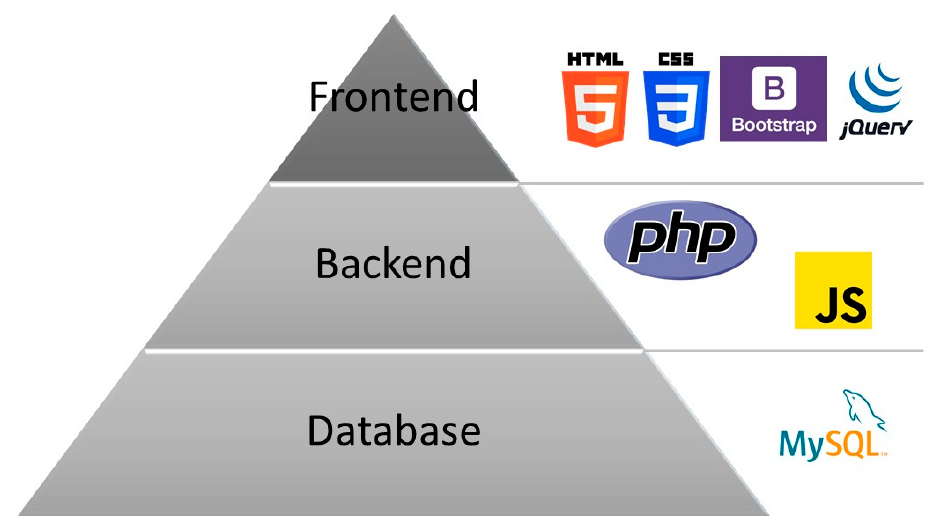
Figure 6. Frontend, backend, and database development.